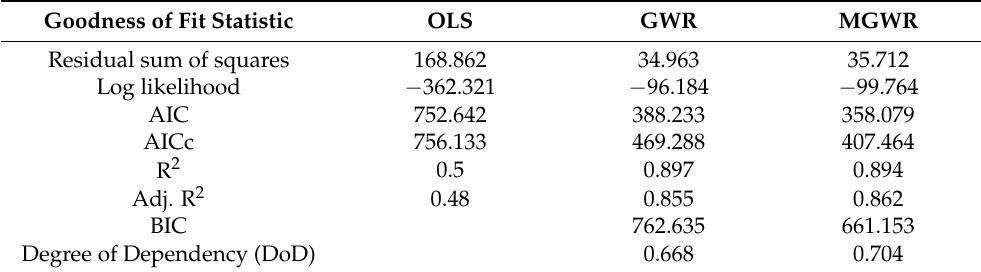
Table 4. The goodness of fit among the OLS, GWR and MGWR models. Goodness of Fit